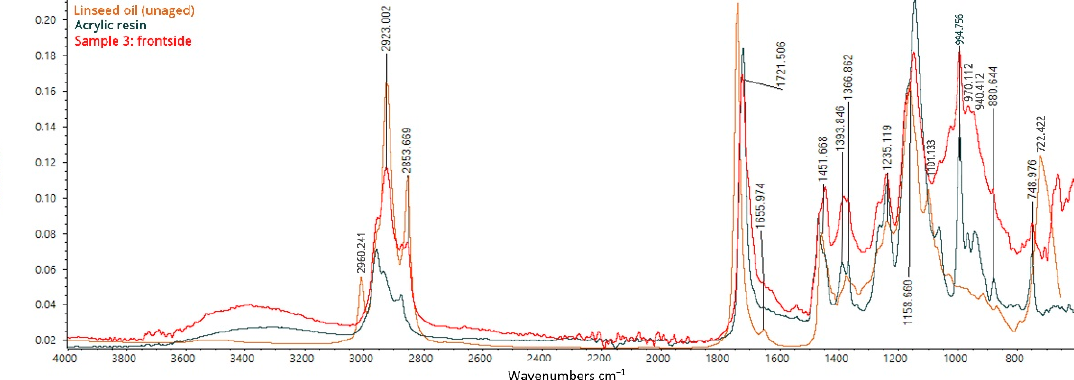
Figure 12. FT-IR ATR spectrum acquired on the front side of sample 3, consisting of the original canvas, the preparation layer, the primer, the paint layers, and the varnish: analysis of the frontside (paint layers and varnish).